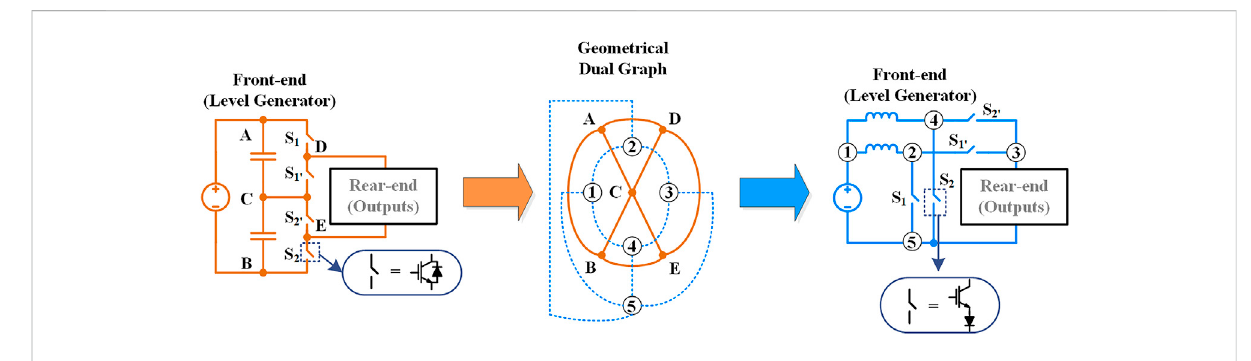
FIGURE 4 Graphs of ANPC phase module and its duality topology.